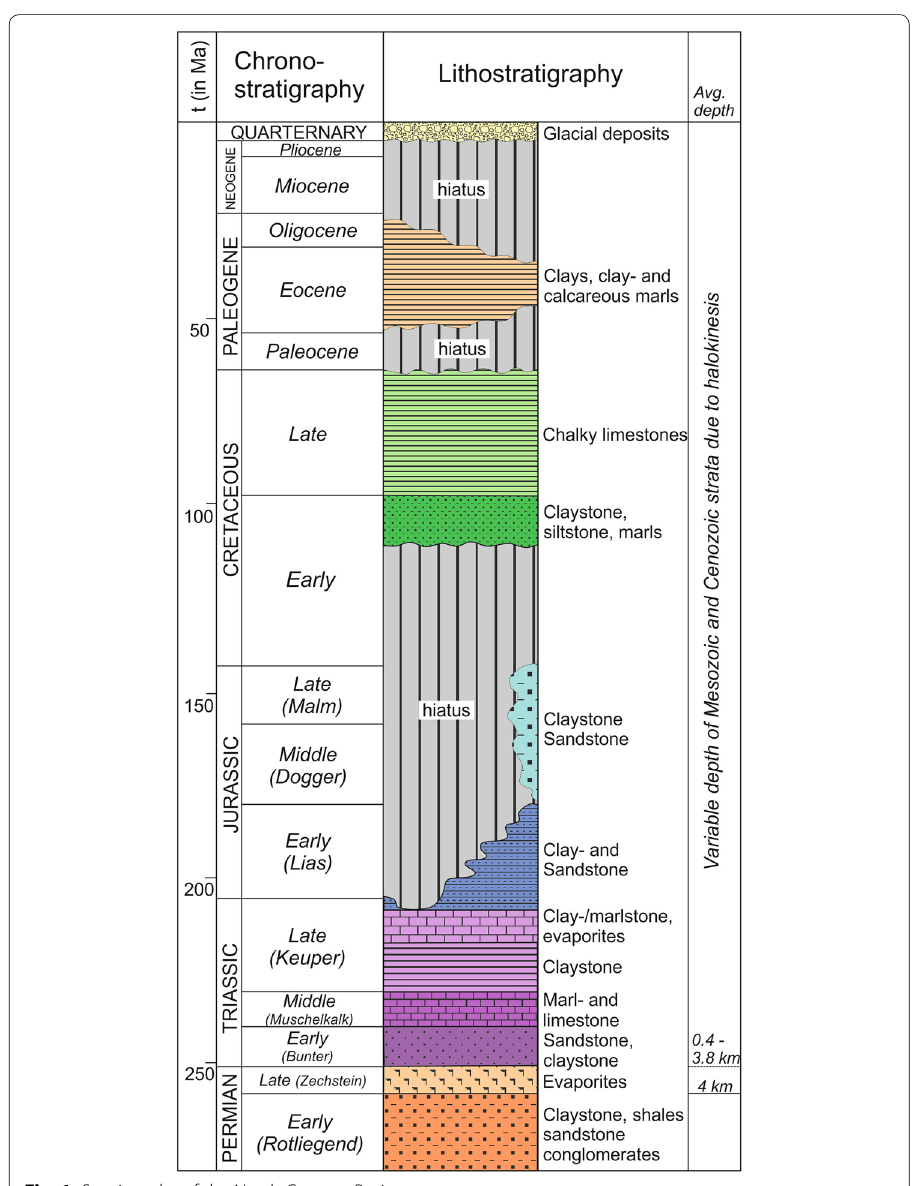
Fig. 1 Stratigraphy of the North German